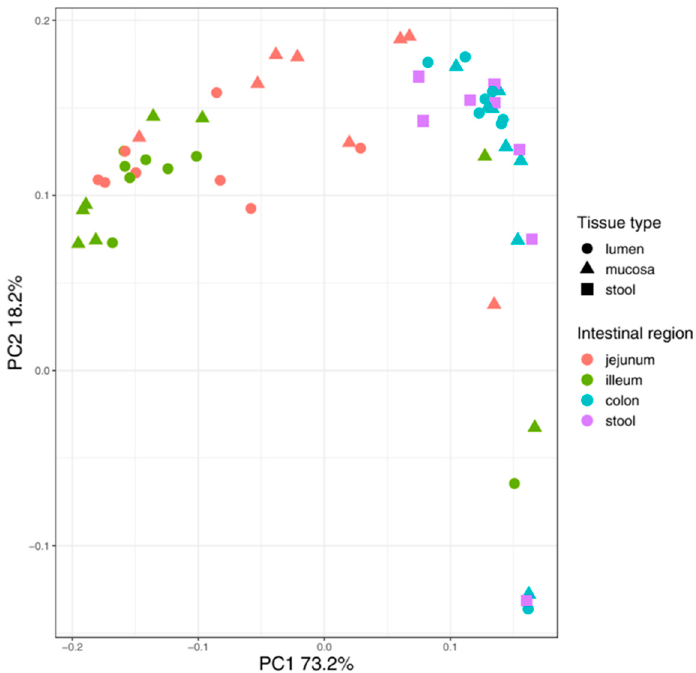
Figure 3. PCoA plot of weighted UniFrac analysis of mouse luminal and mucosa samples. Stool samples were collected from the anus. Clustering along the intestinal regions rather than the tissue type was observed, except for jejunal samples, where mucosa- and lumen-derived samples differed significantly (adj. p -value = 0.045). Table 2. Alpha diversity (Shannon, observed species, PD.faith) and beta diversity (weighted UniFrac) calculations of mouse-derived samples. Comparisons were calculated for the tissue differences MU: mucosa, LU: lumen, *: statistically significant with a p -value smaller than 0.05. Jejunum (MU vs. LU)